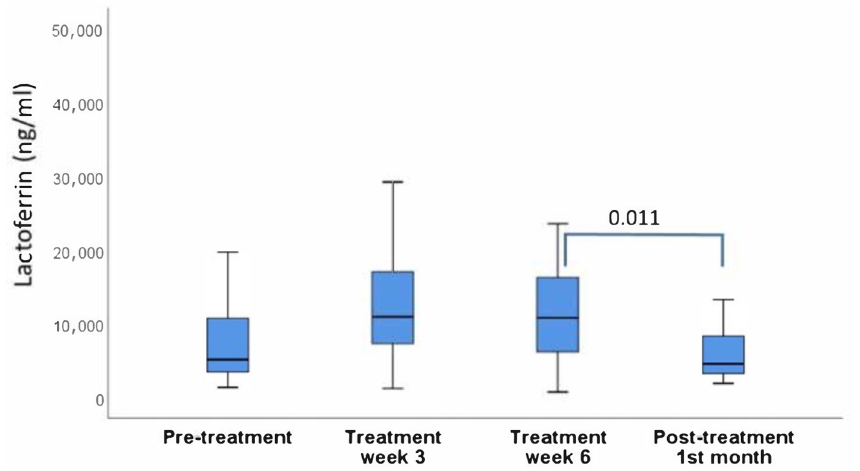
Figure 1. Oral rinse lactoferrin levels before, during and after radiotherapy. Significant differences are marked with connector lines and p values.